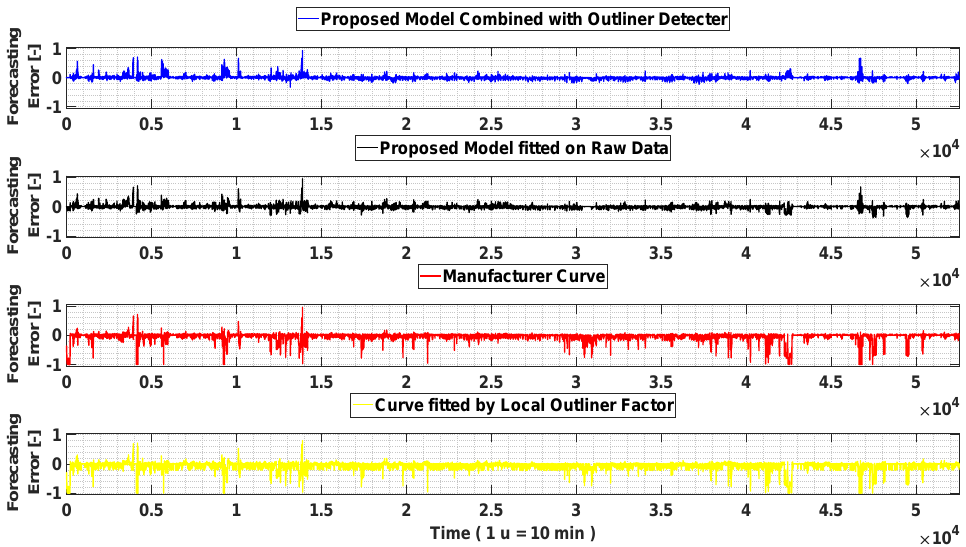
Figure 9. Annual error profile of the estimated power for each discussed